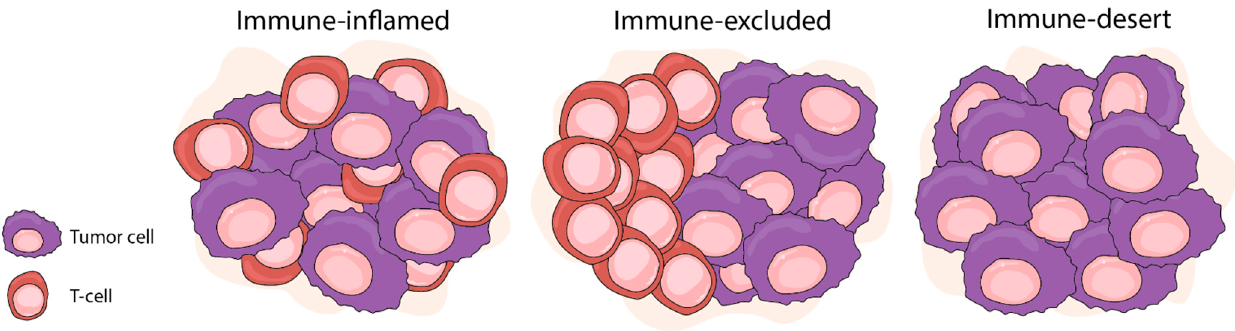
Figure 1. Immunological classification of tumors—inflamed (left) with high degree of cytotoxic T-cell infiltration, immune- excluded (center) with presence of T cells at invasive margins but absence in tumor tissues, and immune desert (right) absence of T cells within tumor and at margins. Prostate cancer has features of both an immune desert and an excluded phenotype (figure based on ANANDAPPA; WU; OTT, 2020) [6].